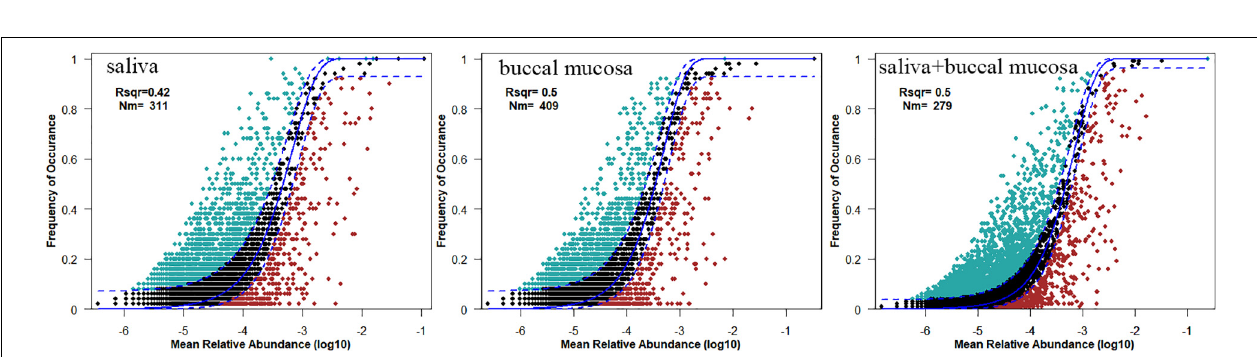
FIGURE 3 | Violin boxplot of the Shannon index (A) , Bray–Curtis distance (B) , and the NMDS analysis (C) of the saliva and buccal mucosa. A significant difference ( p < 0.05) was observed between the saliva and buccal mucosa groups, while variations were not observed with regard to sex ( p > 0.05). NMDS analysis based on the Bray–Curtis distance showed dense clustering in the buccal mucosa but a more dispersed pattern in the saliva without strong clustering, and overlaps were observed between the saliva and buccal mucosa groups.